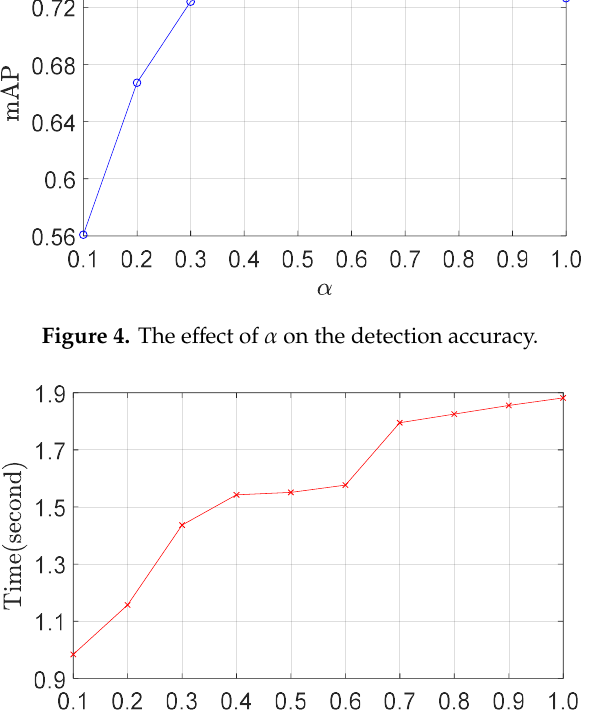
 Figure 5. The e ff ect of α on the detection e ffi Figure 5. The effect of on the detection efficiency.